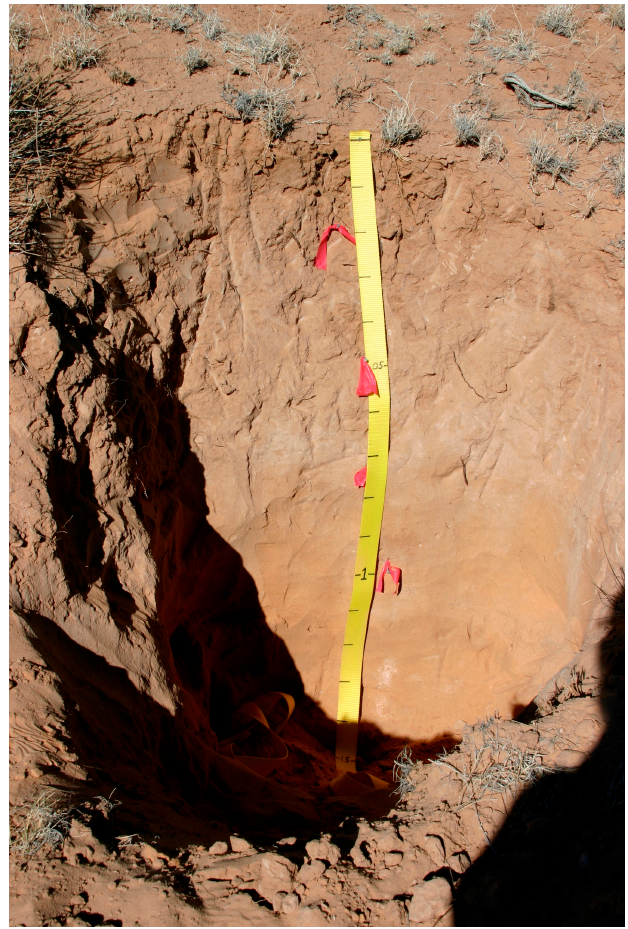
Figure 7. Qe1 soil profile at WP40. The upper 0.8 m of this soil profile in a sandsheet exhibits moderate soil structure (Table 4) evidenced in this photo by vertical ped faces and distinct tool marks (scrapes from excavating tools). The OSL sample from this site yielded an age of 8.62 ± 1.02 ka (Table 5). The yellow tape has tick marks every decimeter.